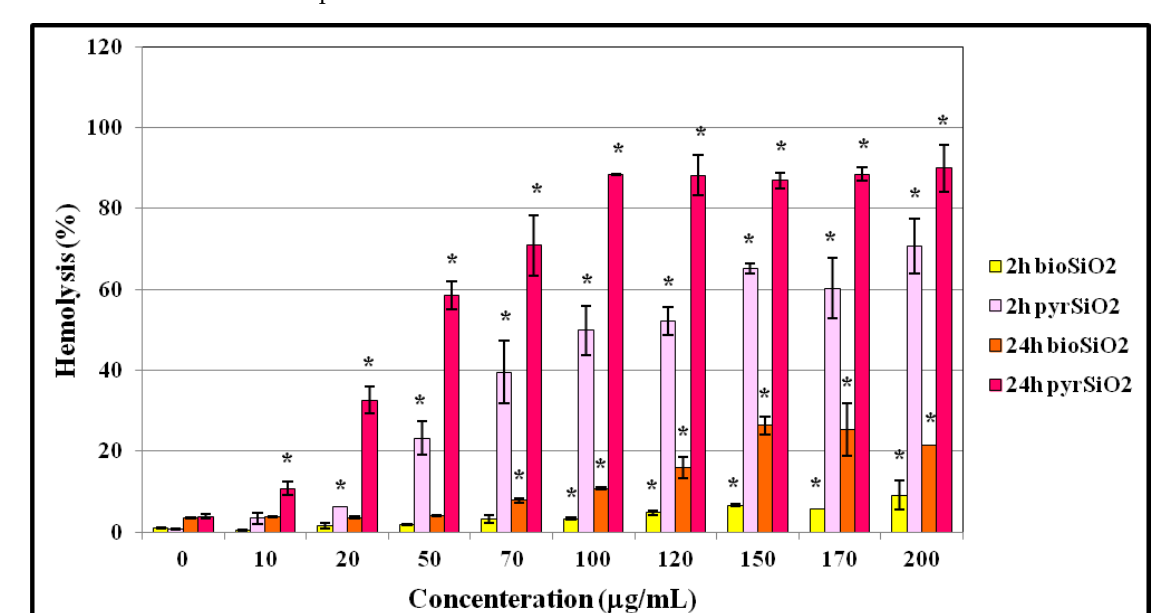
Table 1. The level of osmotic resistance in relation to the concentration of psychological saline (IC 50 ) which is responsible for 50% hemolysis of erythrocytes which were modified by SiO 2 nanoparticles.